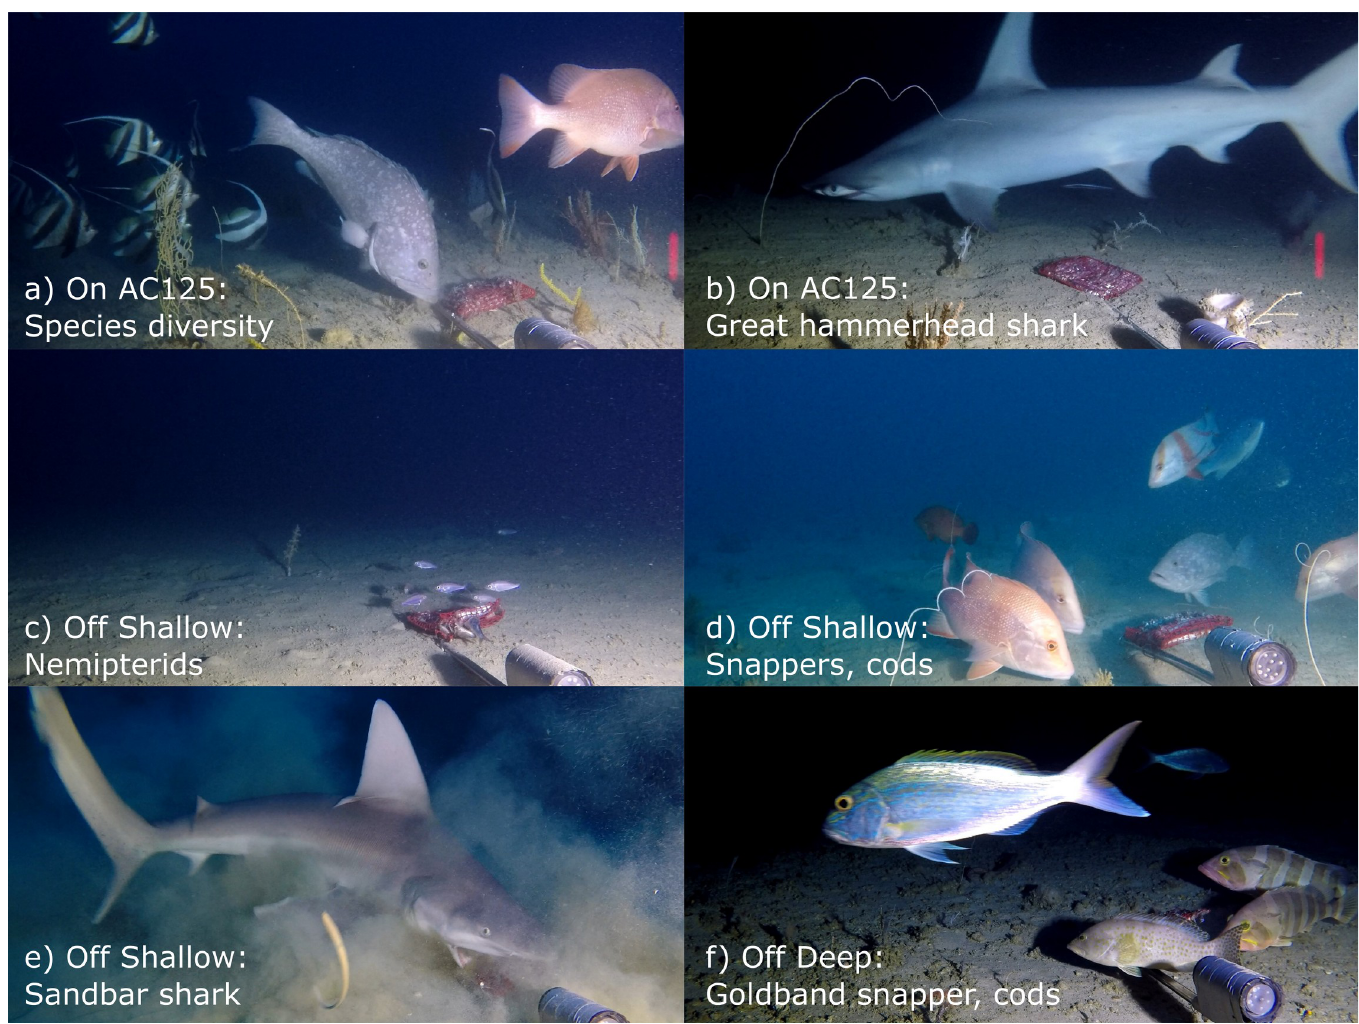
Fig 2. The five areas explored using BRUVS revealed a variety of fish communities. (a, b) Area 2, (c) Area 3, (d) Area 4, (e, f) Area 5.